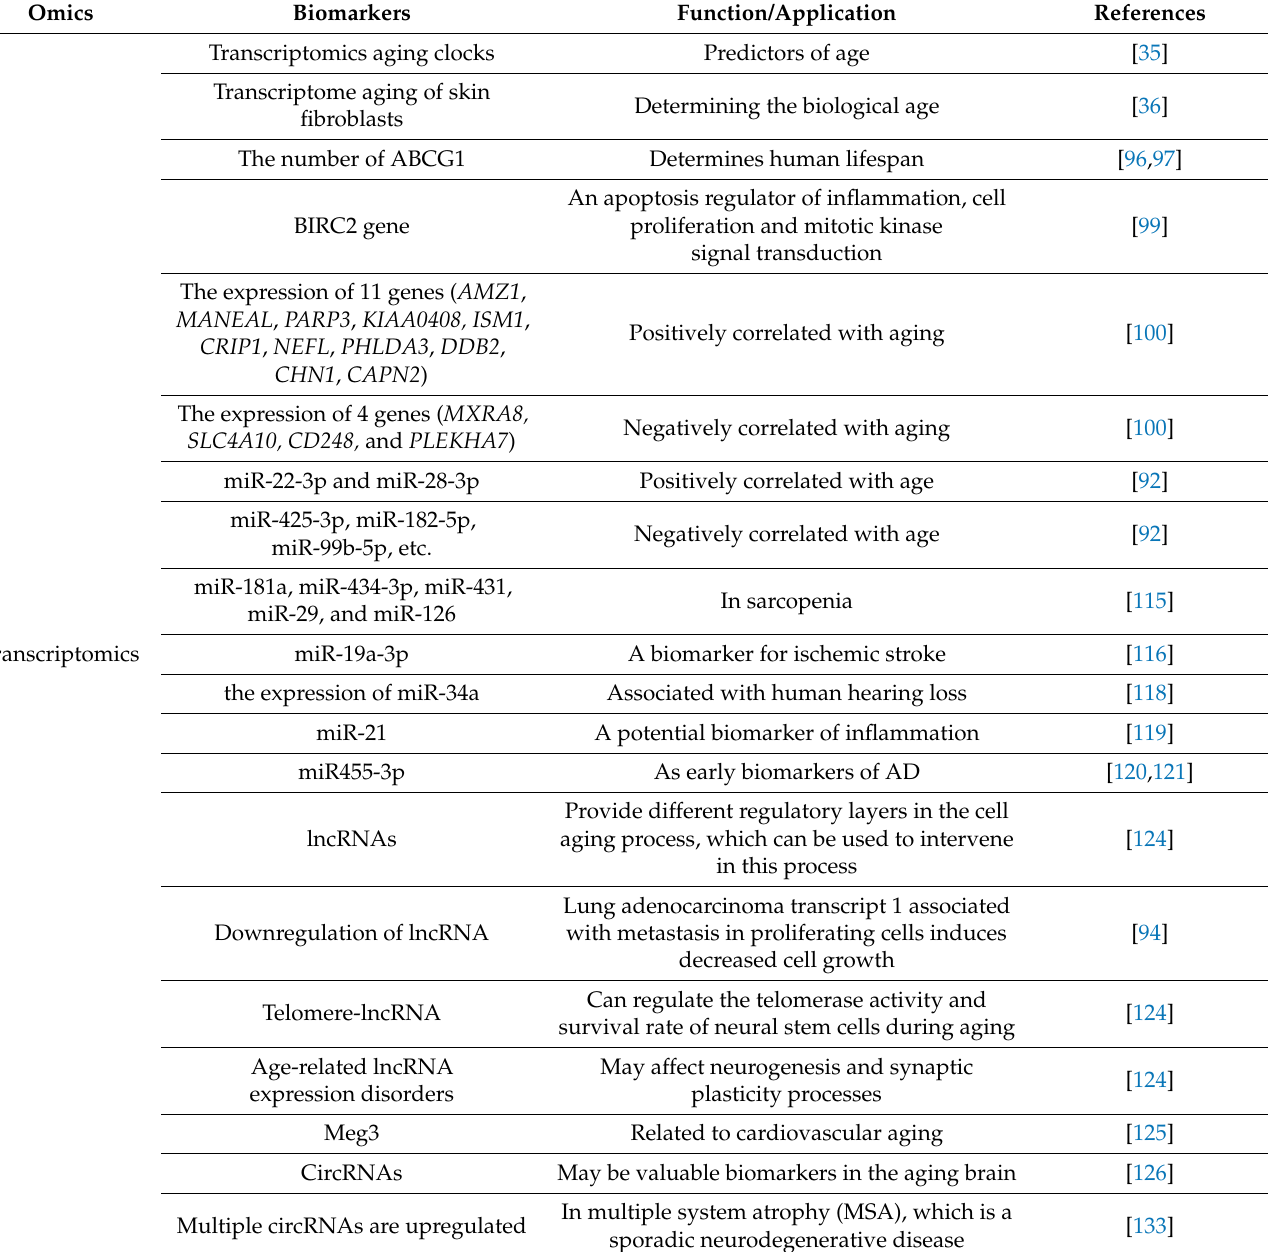
Table 2. Potential aging biomarkers identified in transcriptomics